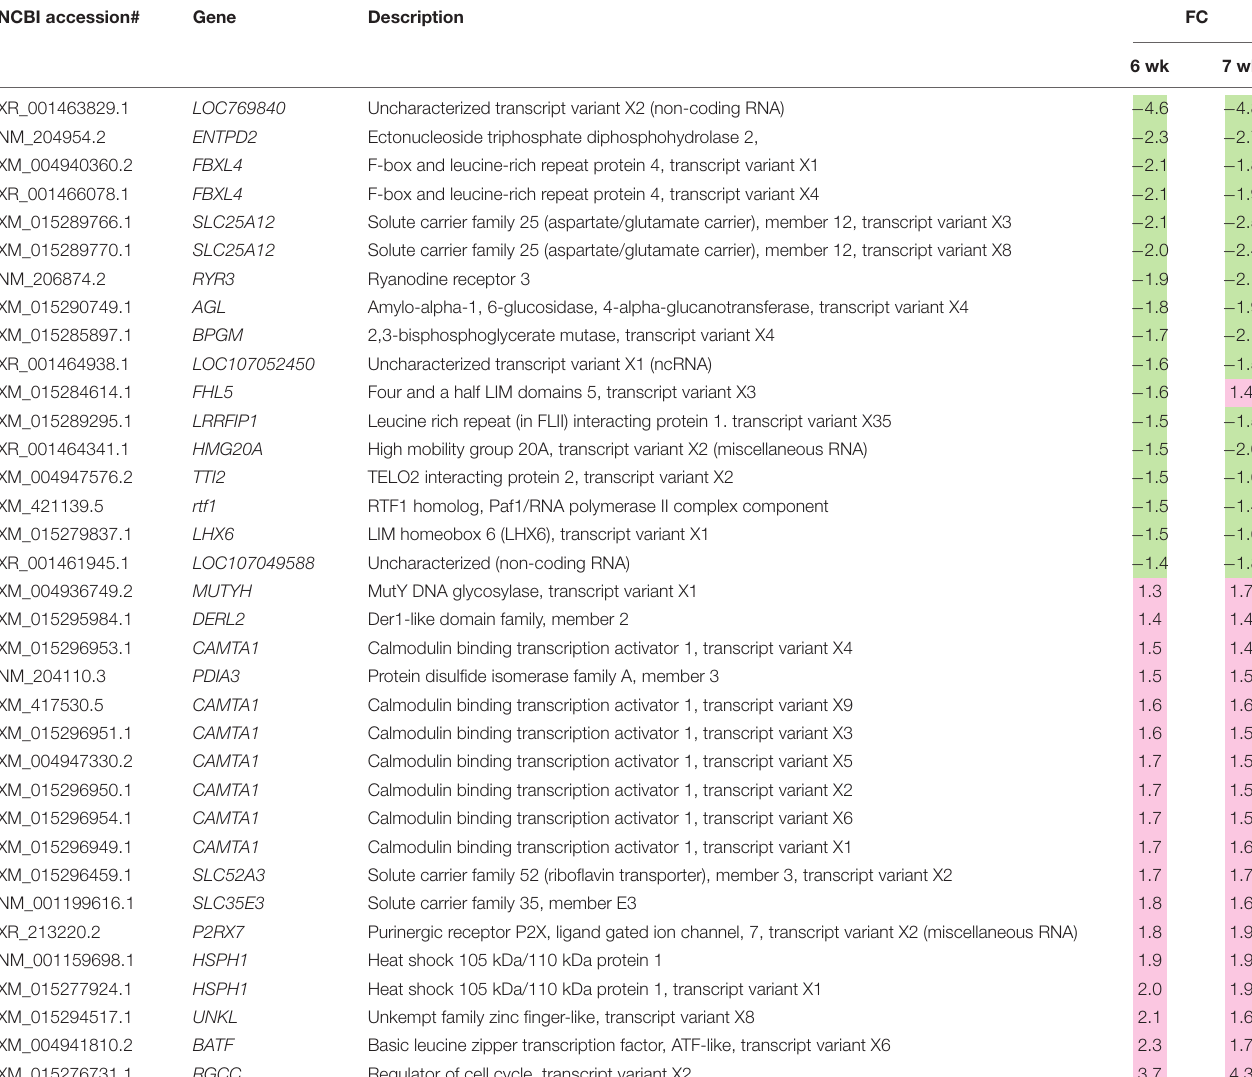
TABLE 3 | Differentially expressed transcripts associated with development of wooden breast myopathies identified in skeletal muscles of both 6-week-old and 7-week-old commercial